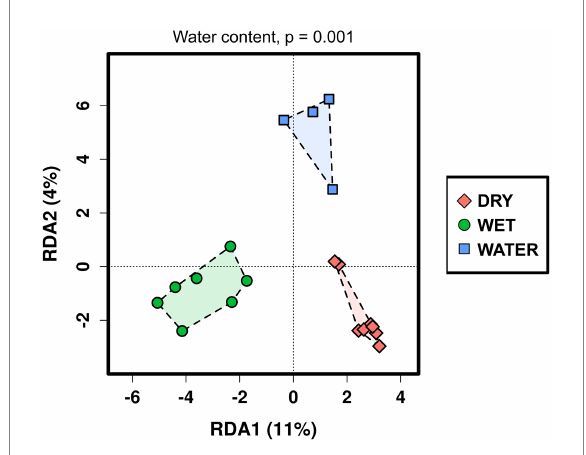
FIGURE 2 Redundancy analysis (RDA) of the Imawarì Yeuta microbial communities based on the water content of the cave samples. The value of p = 0.001 resulting from RDA analysis considering the water content as grouping parameter is indicated above the graph. The p -values of the other environmental parameters that were considered in the RDA analysis but did not result significant, are reported in Supplementary Table